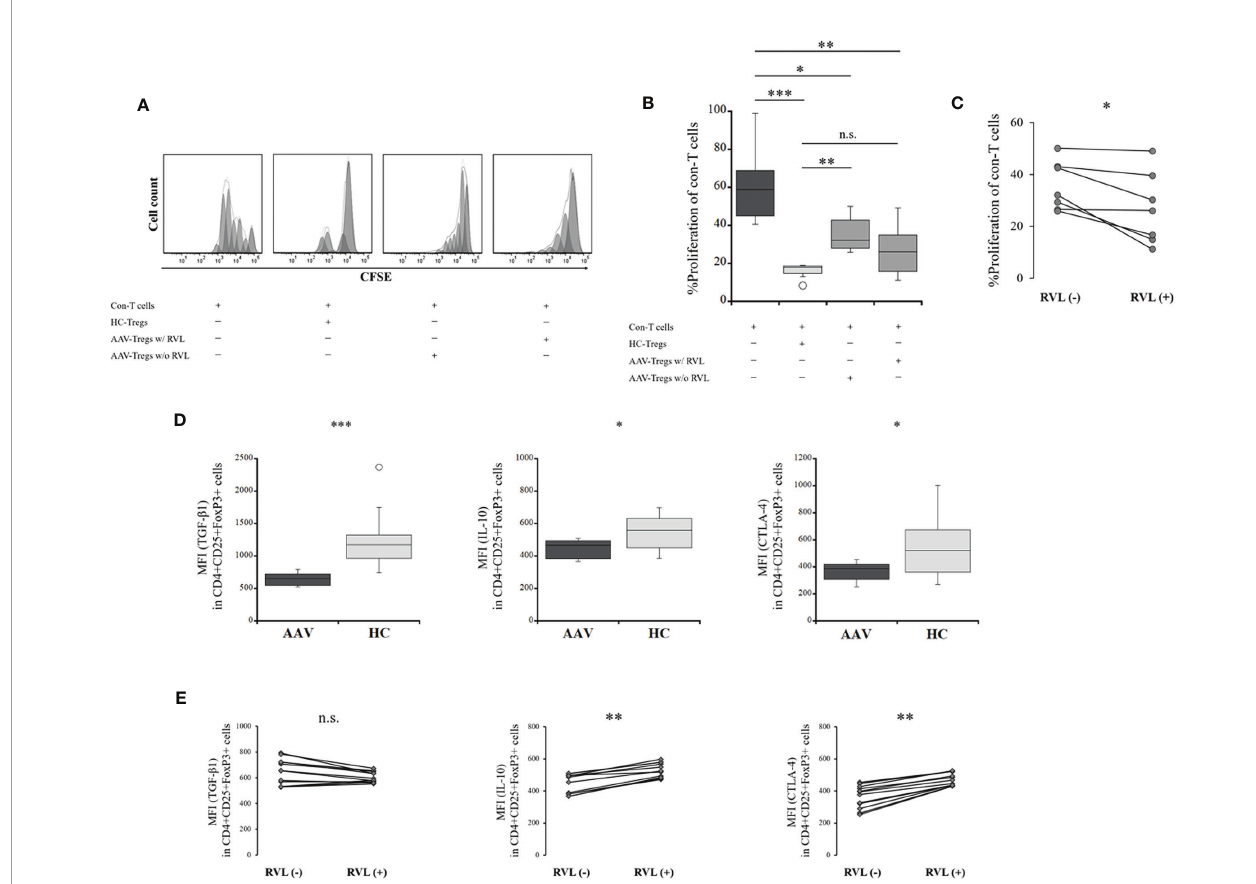
FIGURE 5 | Suppressive assay of regulatory T cells (Tregs) and their co-inhibitory factors before and after treatment with resveratrol (RVL). (A) representative histograms showing proliferation of conventional T (Con-T) cells in the absence of Tregs, in the presence of Tregs from the HC (HC-Tregs), in the presence of Tregs from the patients with AAV (AAV-Tregs) with (w/) RVL treatment, and in the presence of AAV-Tregs without (w/o) RVL treatment. (B) comparisons of the percent (%) proliferation of Con-T cells in the absence of Tregs (n = 12), in the presence of HC-Tregs (n = 9), AAV-Tregs with RVL (n = 7), and AAV-Tregs without RVL treatment (n = 7). (C) alteration of the percent (%) proliferation of Con-T cells with AAV-Tregs before and after RVL treatment (n = 7). (D) comparisons of median fl uorescence index (MFI) of transforming growth factor (TGF)- b 1, IL-10, or cytotoxic T-lymphocyte-associated protein 4 (CTLA-4) in CD4+CD25+FoxP3+ cells between patients with AAV (n = 12) and HC (n = 10). (E) alteration of MFI of TGF- b 1, IL-10, or CTLA-4 in Tregs from patients with AAV before and after RVL treatment (n = 12). AAV, ANCA-associated vasculitis; HC, healthy controls; n.s., not signi fi cant; * p < 0.05; ** p < 0.005; *** p <